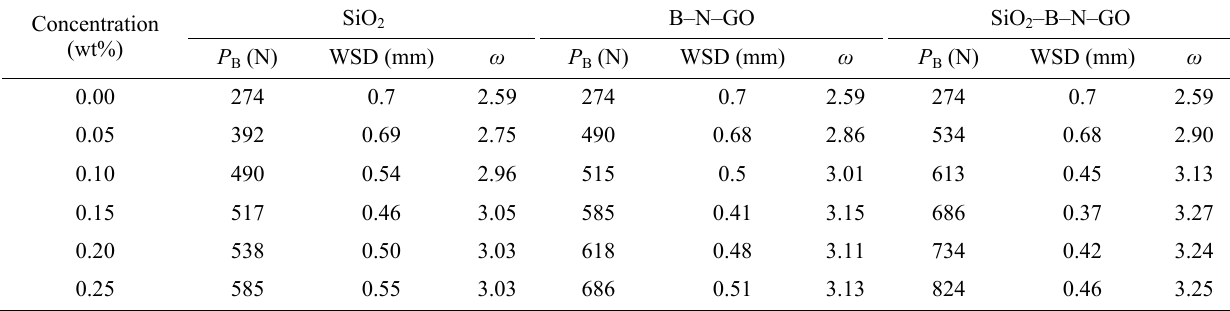
Table 1 Tribological parameters of the